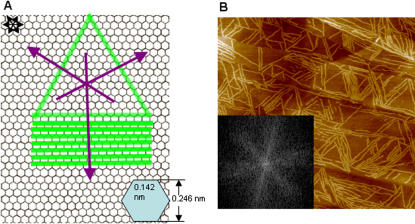
Proposed model of EAK16-II assembly on HOPG.(a) Schematic representation showing the orientation of assembled EAK16-II strands; (b) AFM image of EAK16-II on HOPG surface over a scan area of 1000 nm×1000 nm; the inset shows the 2-dimensional Fourier transform of the AFM image and characteristic 6-fold symmetry.